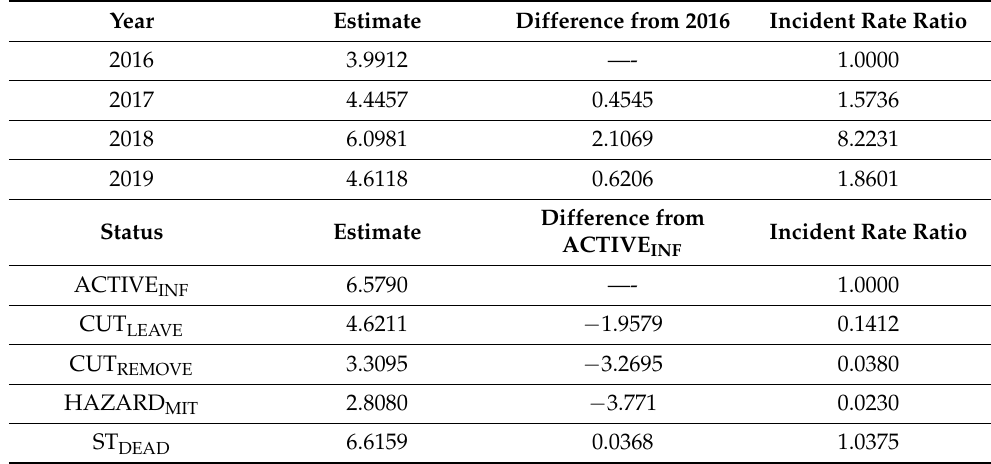
Table 2. Least squares means (natural logged) for southern pine beetle spots by status, and incident rate ratios for the status referenced to spots containing standing dead trees.